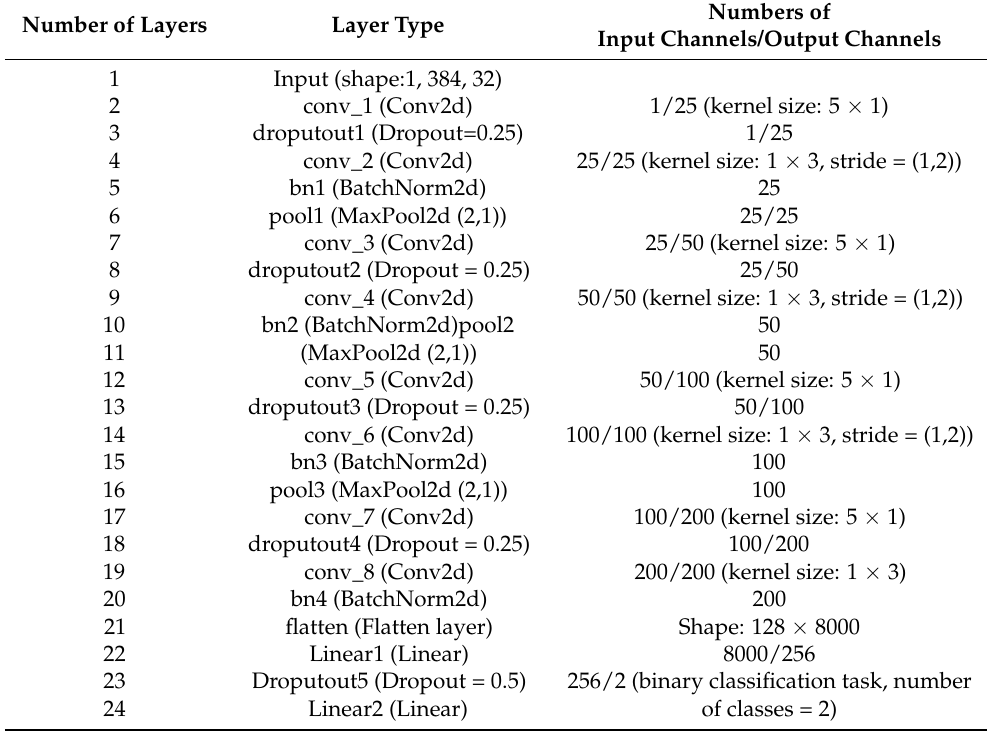
Table 2. The shapes of the proposed model. Number of